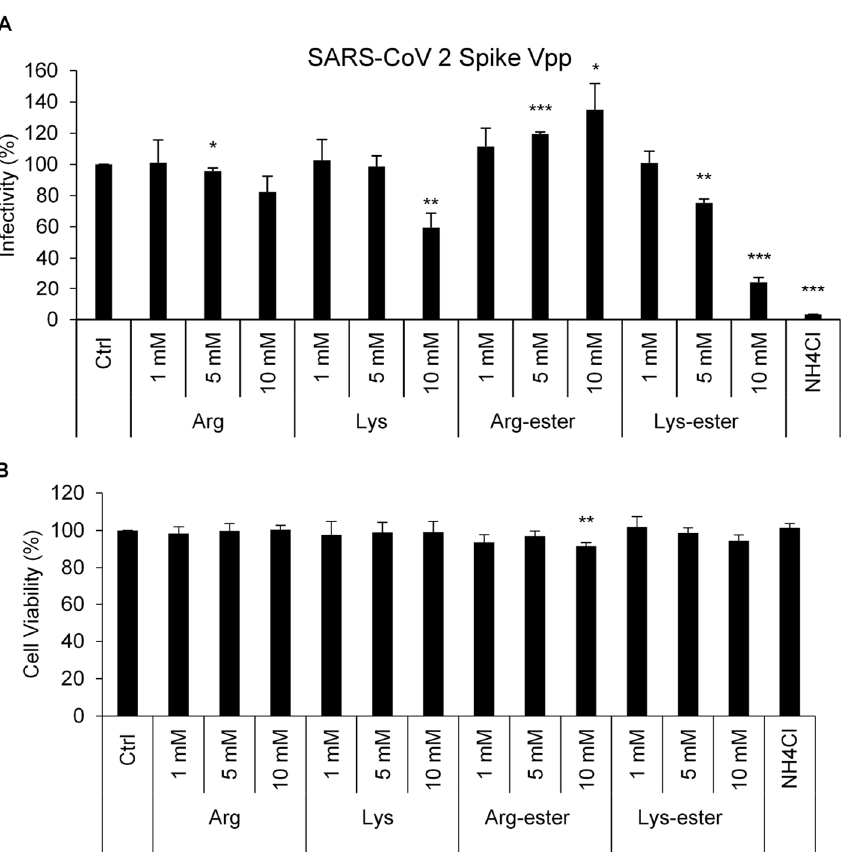
Figure 2. Compound effects on SARS-CoV-2 Spike Vpp infection in HEK293T cells. HEK293T cells were pre-treated with different concentrations of the compounds for 1 h and transduced with SARS-CoV-2 Spike Vpp for 1 h in the presence of the compounds in the media. ( A ) Infectivity and ( B ) cell viability were measured at 3 days post-infection using luciferase assay and MTS assay, respectively. The values represent the means ± standard deviation (SD) of data from three independent experiments. Ctrl: medium only. *, p < 0.05; **, p < 0.01; and ***, p < 0.001 compared with controls (n = 3).